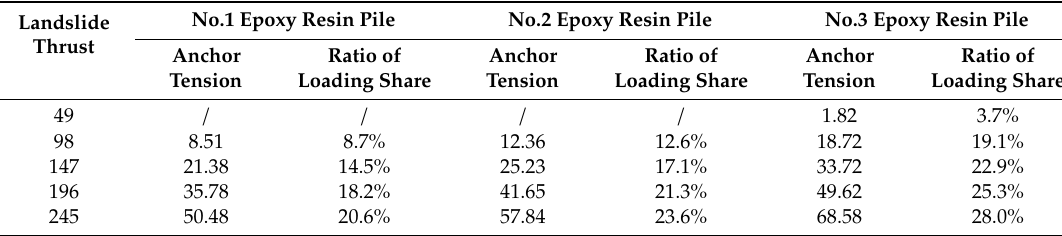
Table 3. Anchor tension and the ratio of loading share in aluminum alloy pile model (Unit: N). Landslide Thrust